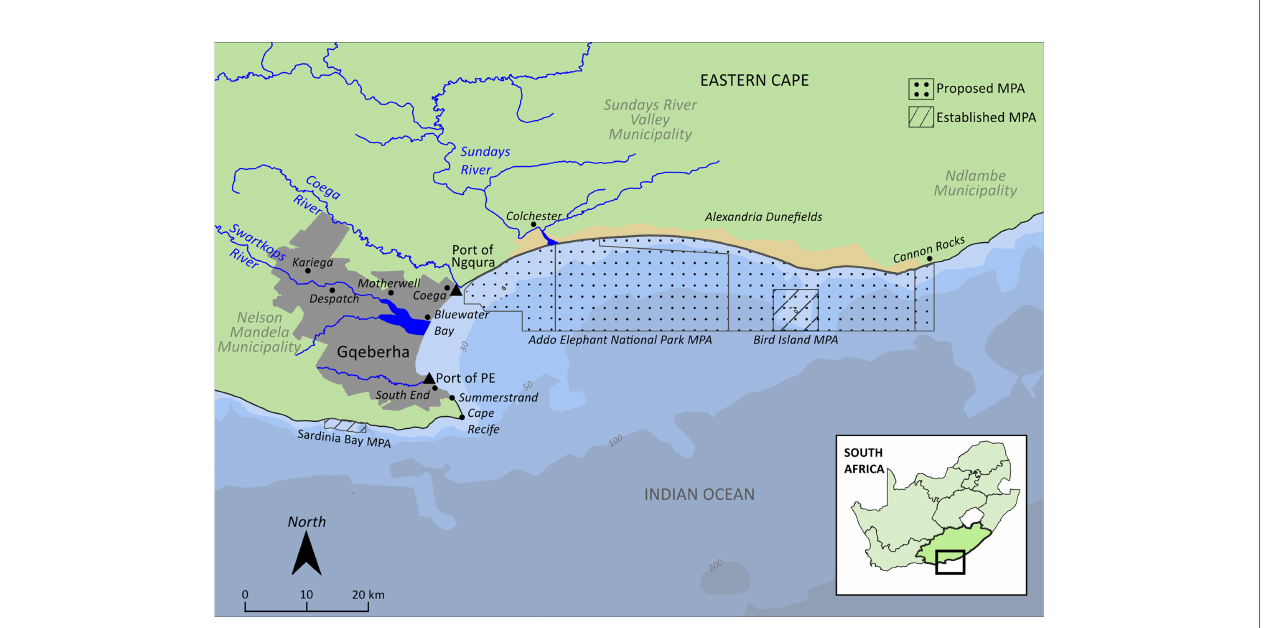
FIGURE 1 | Map of Algoa Bay, stretching from Cannon Rocks in the east to Sardinia Bay in the